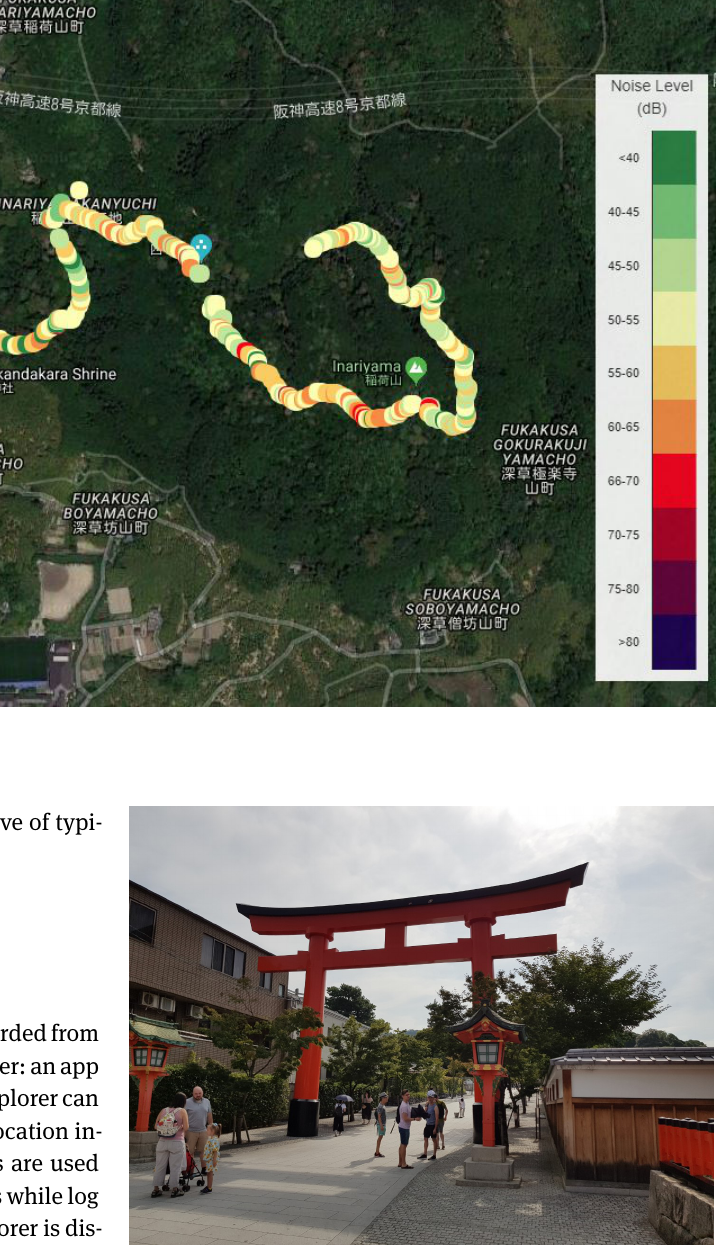
Figure 4: The main entrance to the Fushimi Inari shrine opposite the train